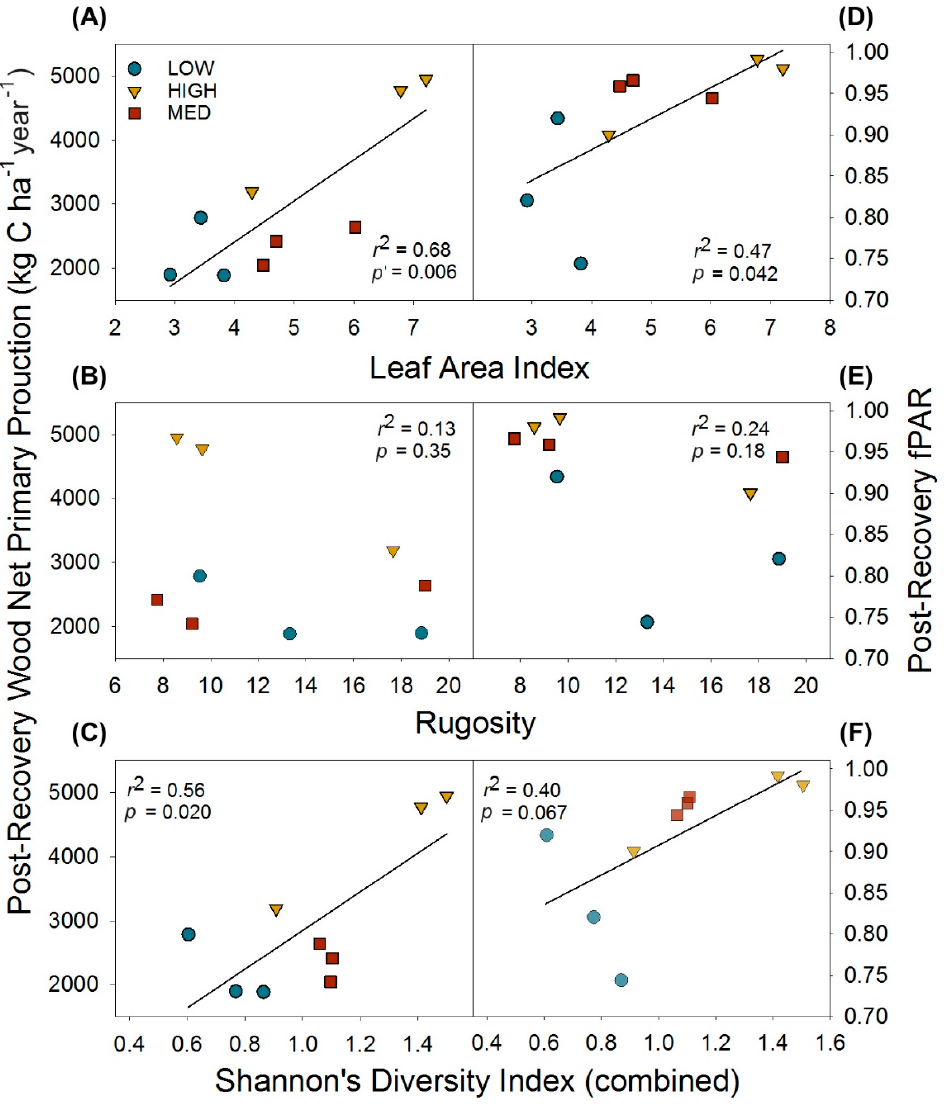
Figure 4. Post-recovery (2016) relationships of physical and biological structural metrics and their effects on wood net primary production and the fraction of absorbed photosynthetically active radiation (fPAR). Relationships shown are for leaf area index ( A , D ); and canopy rugosity ( B , E ); and tree diversity as Shannon’s Diversity Index ( C , F ). Data points are for individual plots.